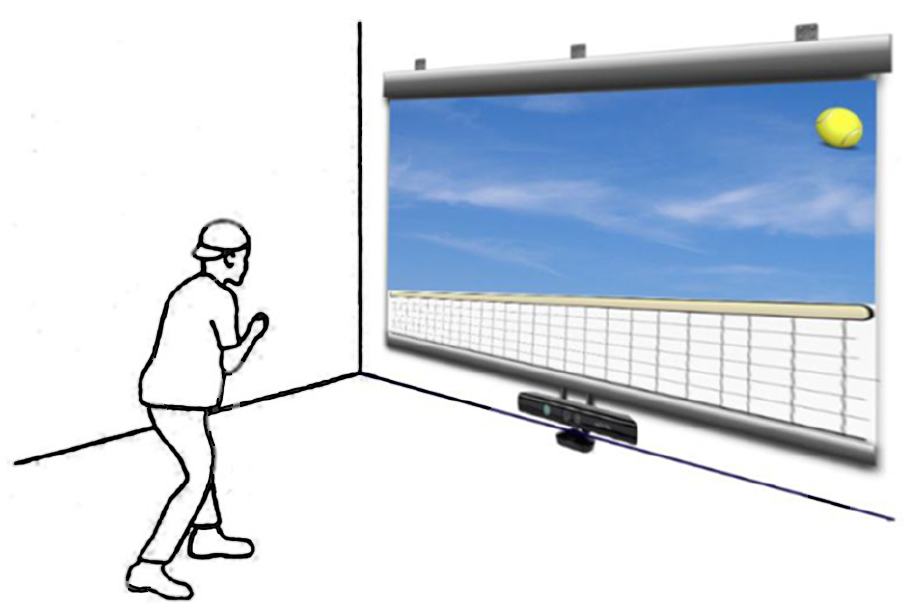
Figure 1. Tennis Attack wireframe.